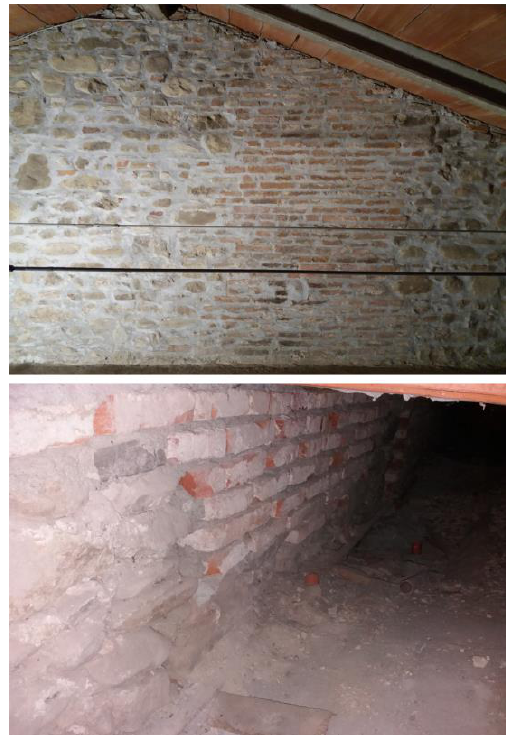
Figure 4. Up: the intermediate wall in the attic where the counter wall supporting the mural painting wall-panel is not present. Down: the counter wall supporting the mural painting wall-panel above the vault but below the attic